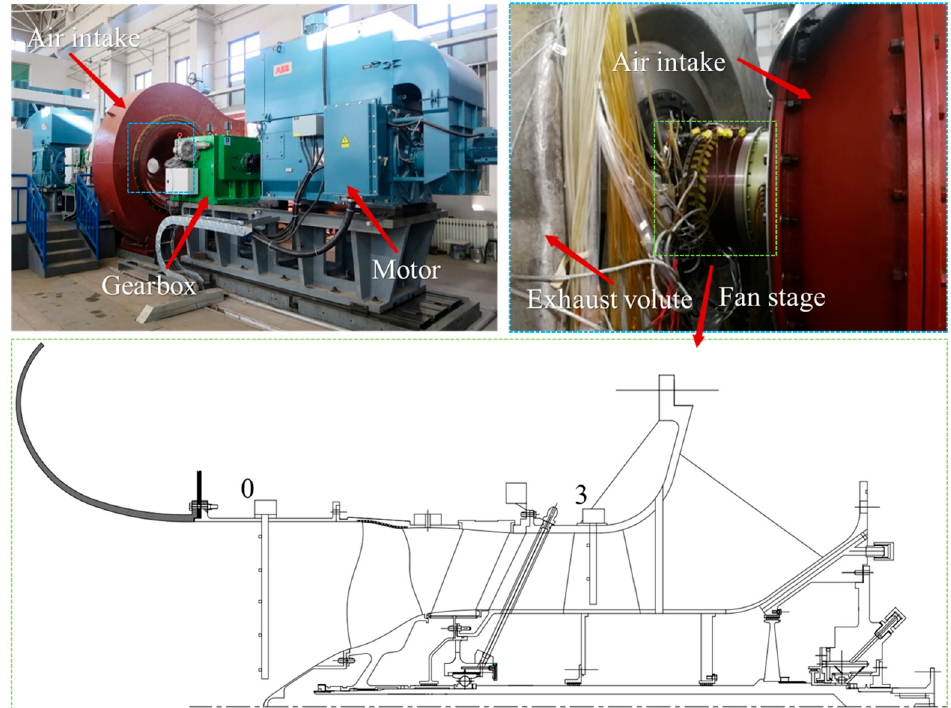
Figure 5. The physical display of the test rig and fan stage details.